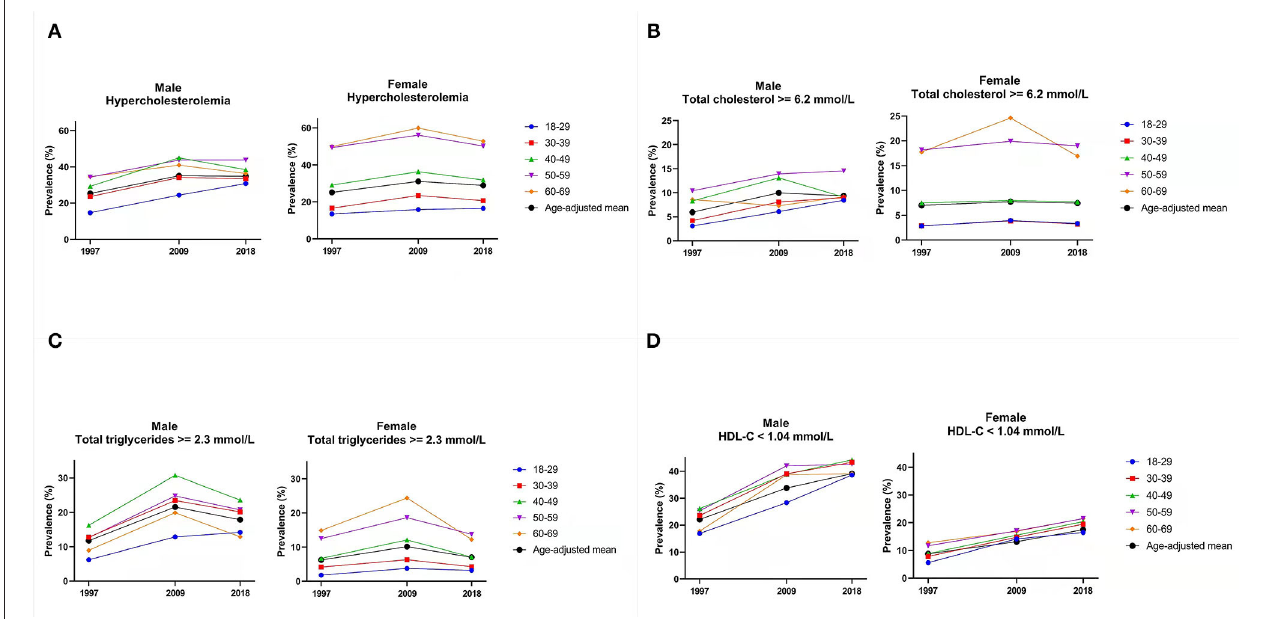
FIGURE 1 | Age-adjusted prevalence of lipid profiles trends from 1997 to 2018. Footnote: Hypercholesterolemia is defined as total triglycerides ( ≥ 2.3 mmol/L), total serum cholesterol ( ≥ 6.2 mmol/L), low-density lipoprotein cholesterol (LDL-C) ( ≥ 4.1 mmol/L), and high-density lipoprotein cholesterol (HDL-C) ( < 1.04 mmol/L). (A) Prevalence of hypercholesterolemia. (B) Prevalence of high total cholesterol. (C) Prevalence of high total triglycerides. (D) Prevalence of low